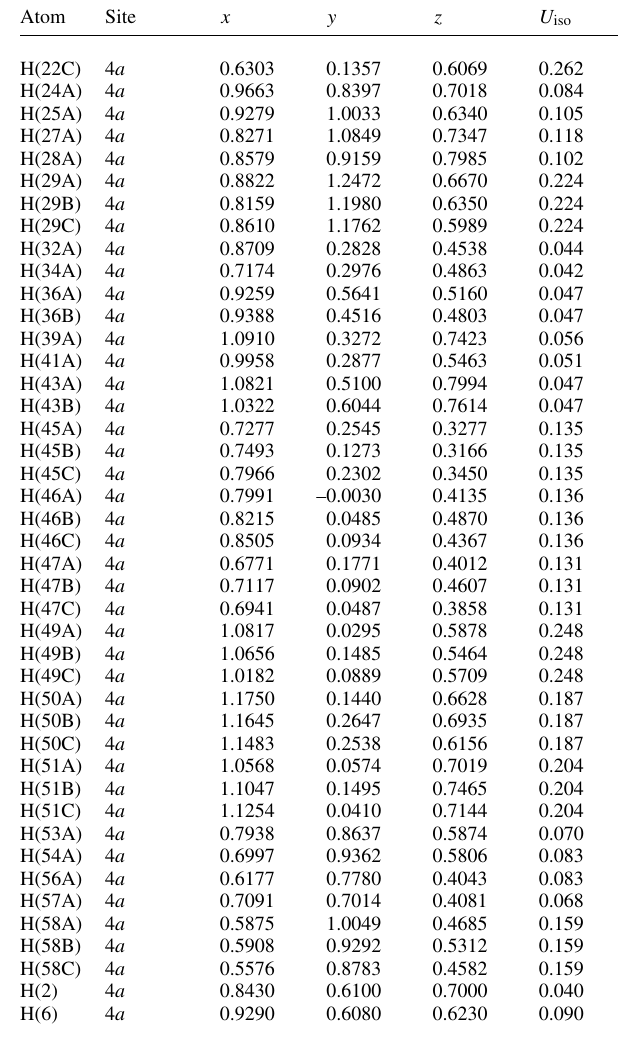
Table 1. Data collection and